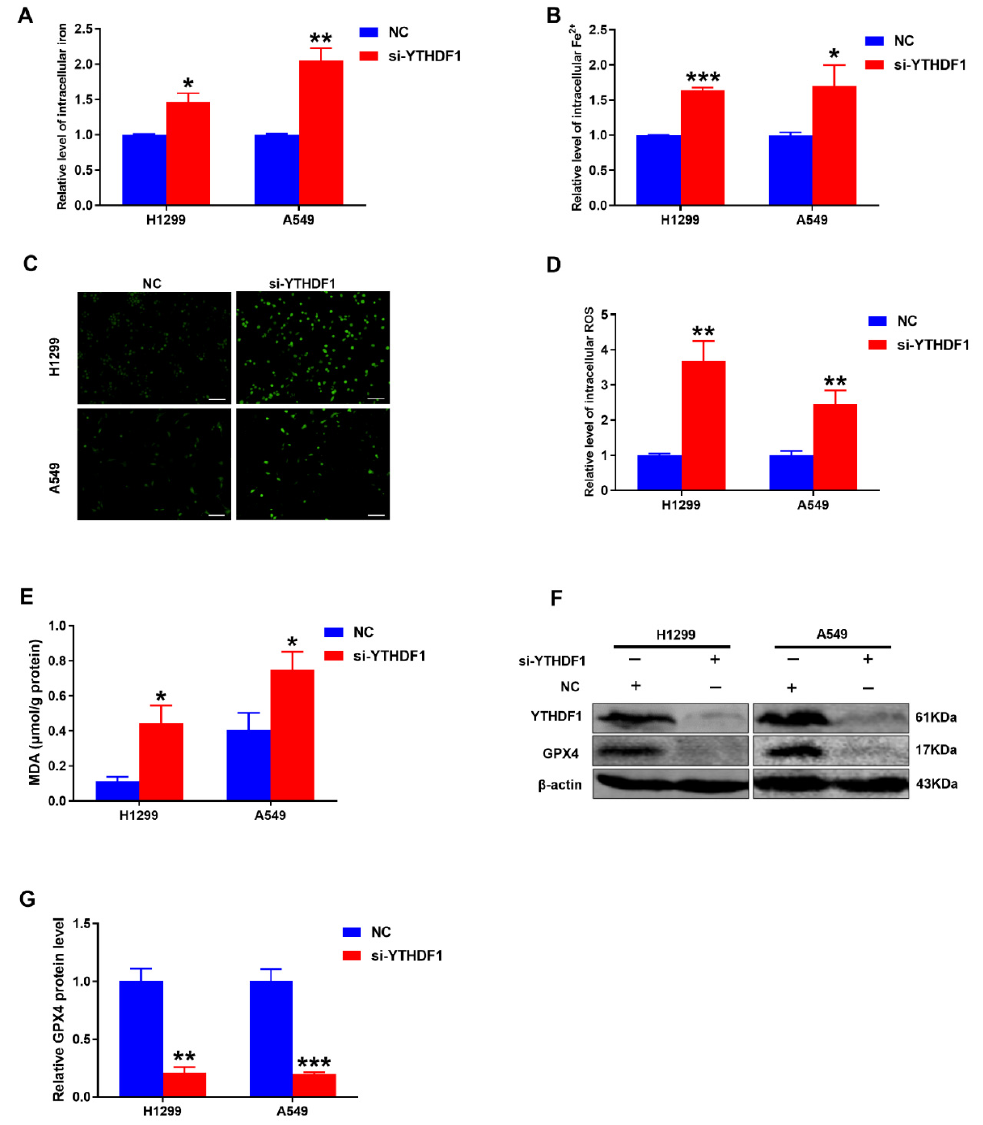
Figure 3. YTHDF1 knockdown induced dysregulated iron metabolism and promoted ferroptosis of lung cancer cells. ( A , B ) Intracellular iron level and Fe 2+ level in H1299 and A549 cells after transfection with si-YTHDF1 at 24 h. ( C ) Representative fluorescence images of H1299 and A549 cells stained with DCFH-DA to measure ROS production. Scale bar, 100 µ m. ( D ) Statistical analysis of the green fluorescence about ROS. ( E ) MDA level was detected in YTHDF1 depletion lung cancer cell lines. ( F ) Western blot analysis showed the effect of YTHDF1 knockdown on GPX4 in lung cancer cell lines. ( G ) Statistical analysis for the result of GPX4 protein assays in ( E ). * p < 0.05; ** p < 0.01 and *** p <